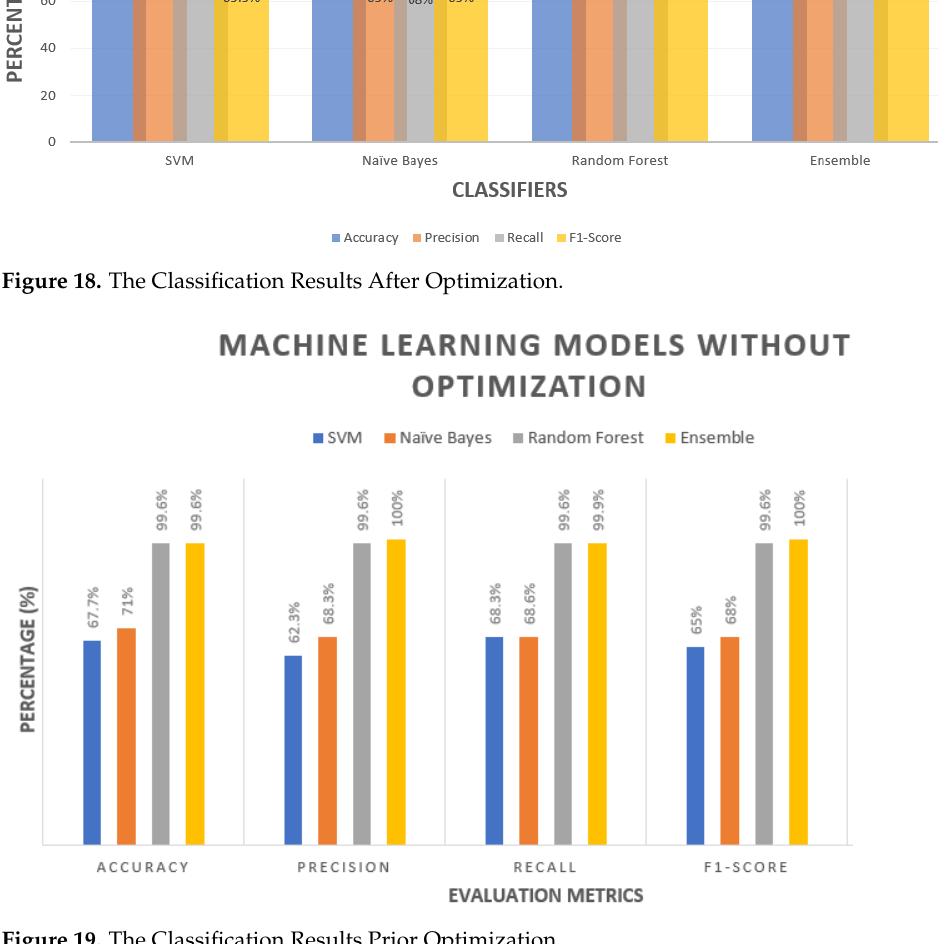
Figure 19. The Classification Results Prior Optimization.